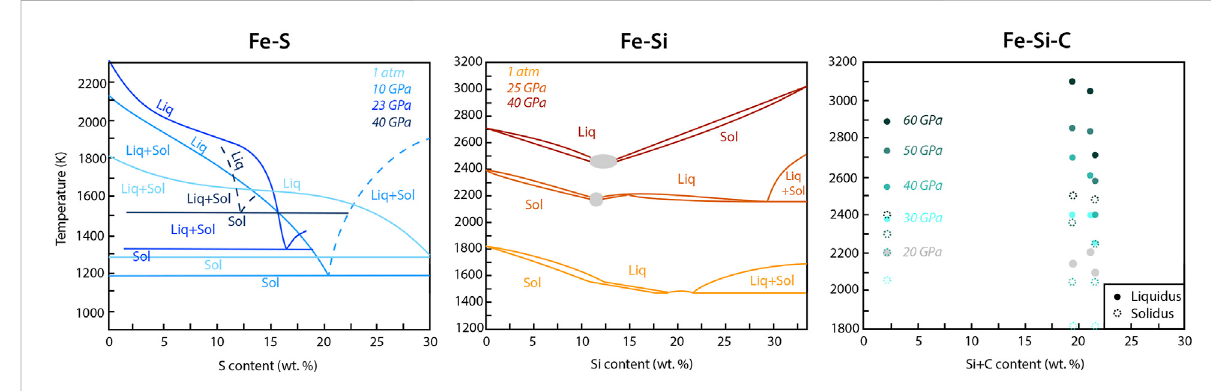
FIGURE 10 Phase diagrams for three iron alloys (Fe-S, Fe-Si,and Fe-Si-C) under pressure and temperature. Data for the Fe-S system are from Waldner and Pelton (2005) (1bar), Chen et al. (2008) (10 GPa), and Stewart et al. (2007) (23 and 40 GPa), data for the Fe-Si system are from Edmund et al. (2022), and data for the Fe-Si-C system are from Miozzi et al. (2022).